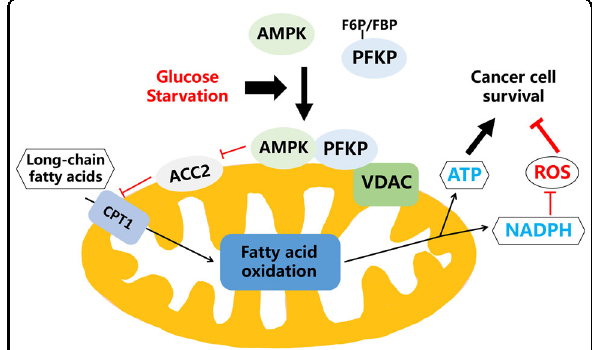
Fig. 7 Schematic model of the PFKP-AMPK-ACC2-mediated long- chain fatty acid oxidation which promotes cancer cell survival under GS. PFKP mediates the recruitment and activation of mitochondrial AMPK under GS, which results in enhanced mitochondrial ACC2 phosphorylation and facilitates long-chain fatty acid oxidation to maintain metabolic homeostasis, leading to the promotion of cancer cell